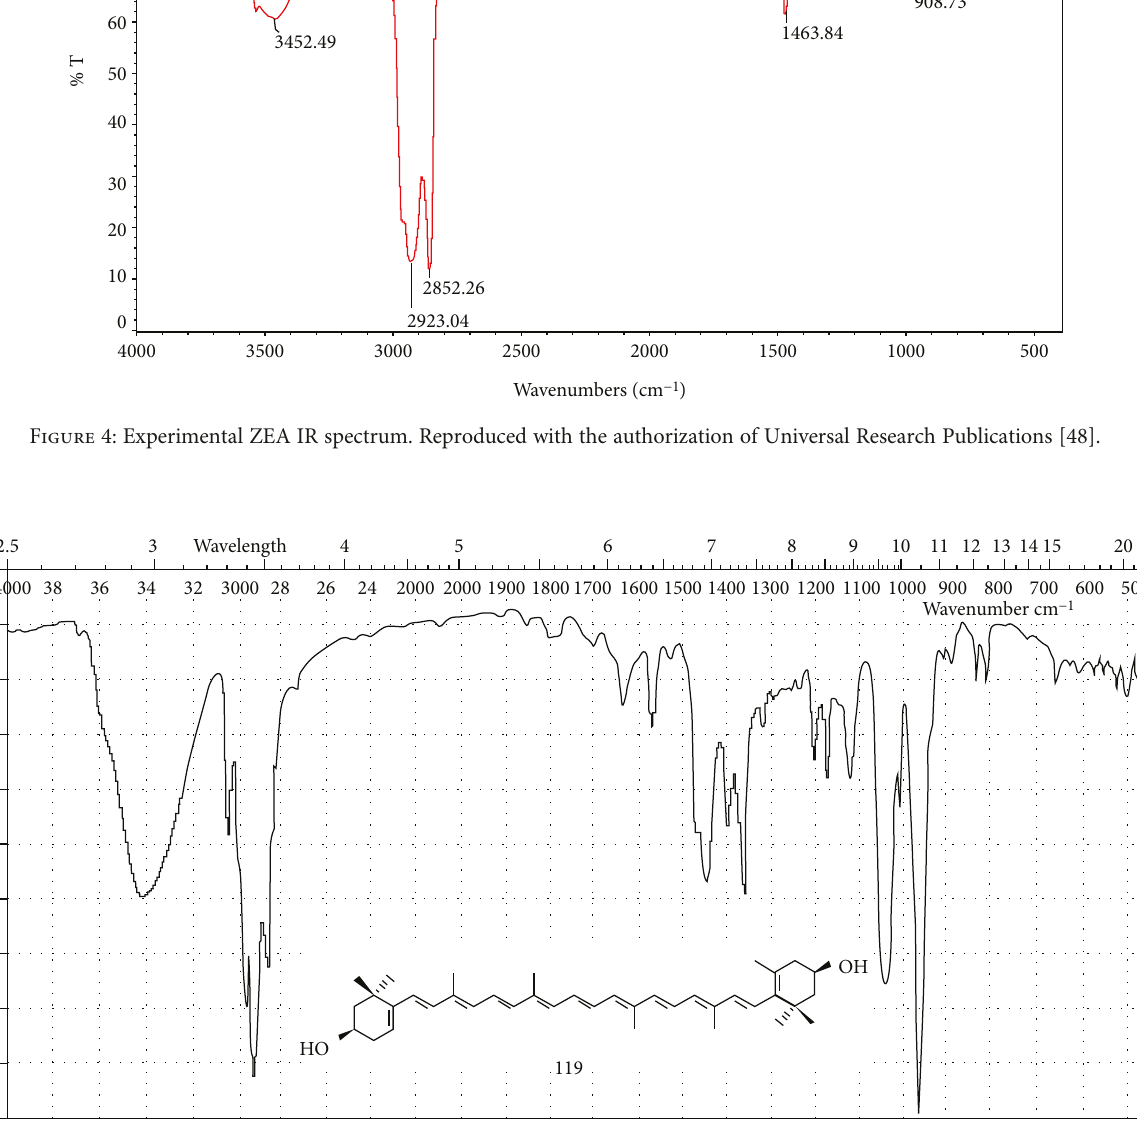
Figure 5: Experimental ZEA IR spectrum. Reproduced with the authorization of Birkhäuser Verlag AG Publisher